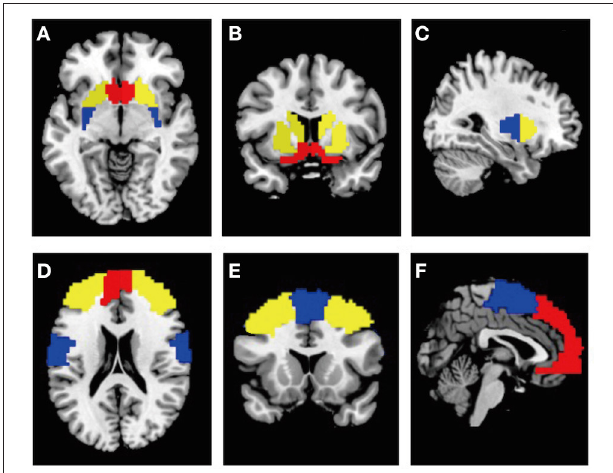
FIGURE 1 | (A–C) ROIs of the bilateral tripartite functional territories of striatum from the horizontal, coronal, sagittal plane view. Red: ventral striatum; yellow: dorsomedial striatum; blue: dorsolateral striatum. (D–F) ROIs of their associated cortical structures from the horizontal, coronal, sagittal plane view. Red, vmPFC; yellow, dlPFC; blue, sensorimotor